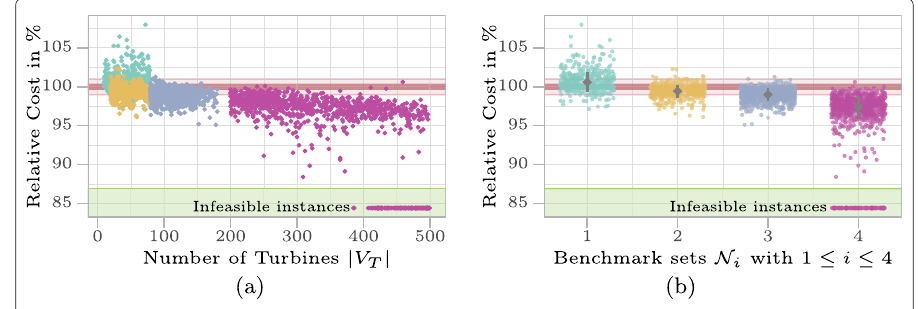
Fig. 3 Evaluation of the Negative Cycle Algorithm using different criteria: ( a ) number of turbines | V T | , and ( b ) benchmark sets N i with 1 ≤ i ≤ 4. We compare all criteria with the relative cost—meaning the ratio of